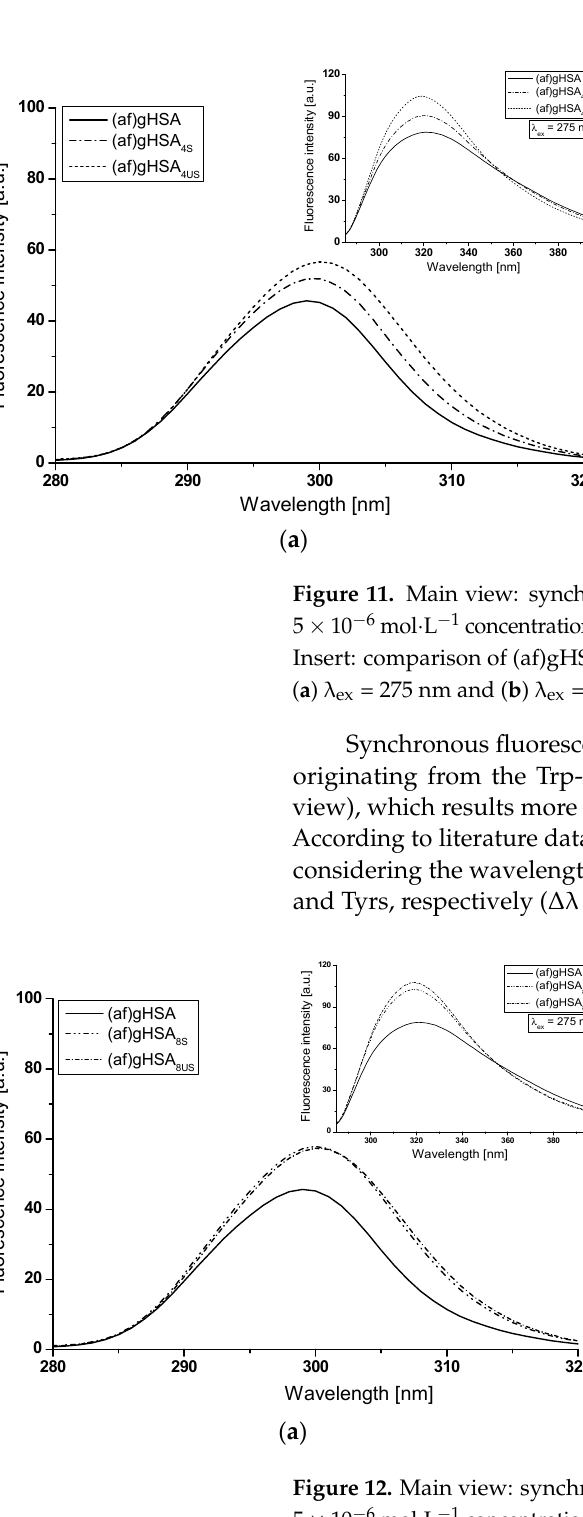
Insert: comparison of (af)gHSA and (af)gHSA phys emission fluorescence spectra excited at ( a ) λ ex =